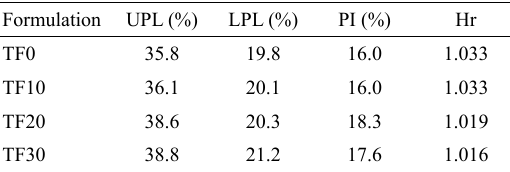
Table 4. Plastic properties and Hausner ratio of the aluminous porcelain powders. Formulation UPL (%)